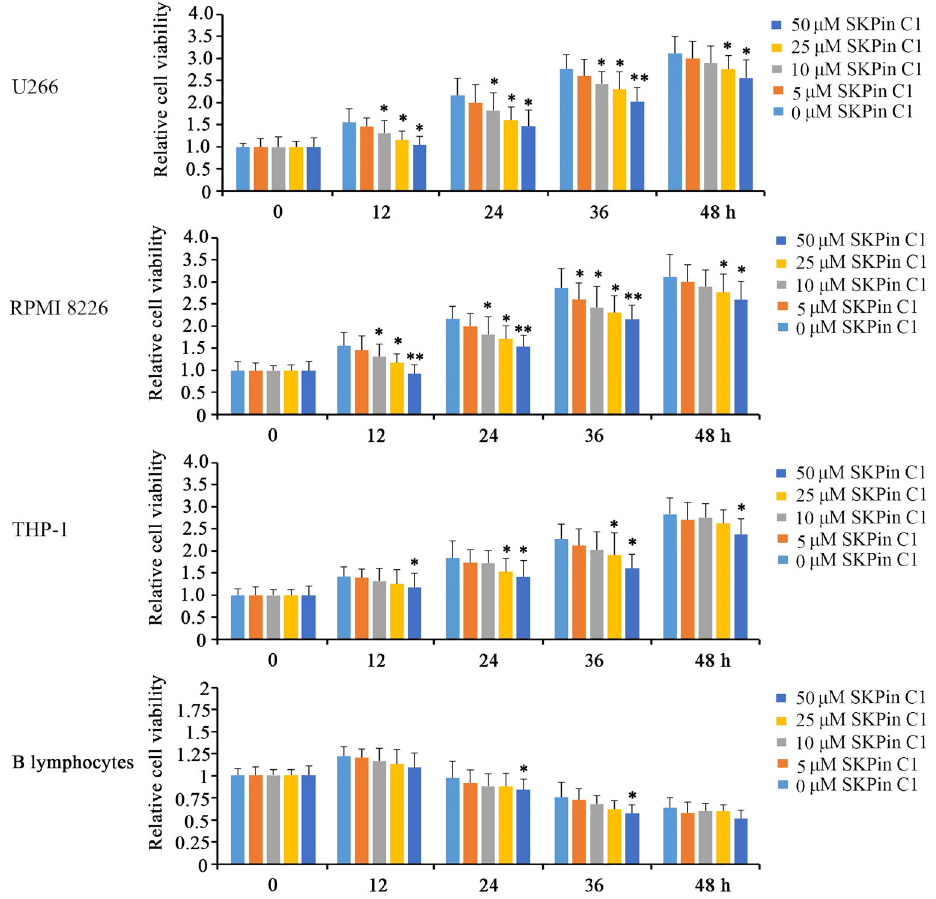
Figure 1. Effect of different dosages of SKPin C1 on the viability of B lymphocytes, U266, RPMI 8226, and THP-1 cells. Cell viability was meas- ured by MTT at different time points. Data are reported as means ± SD. *P o 0.05, **P o 0.01 vs non-treated group (control, 0 m M)